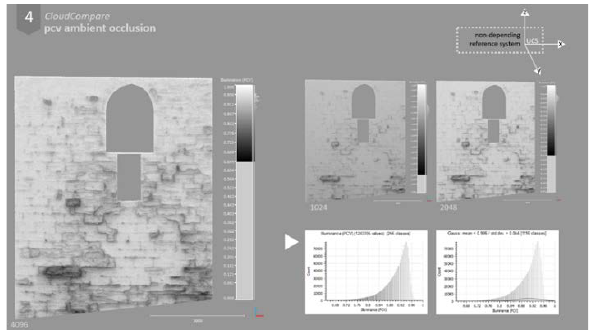
Figure 9. The luminance map in ambient occlusion.